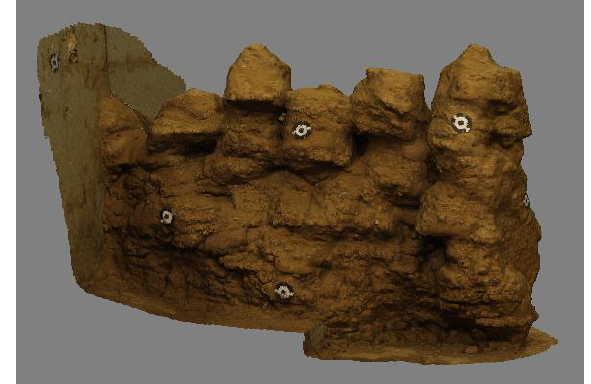
Figure 6. Dense point cloud model